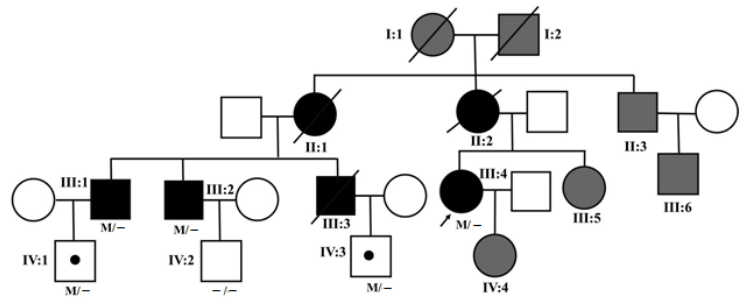
Figure 1. The Chinese pedigree of FAP. Arrow: the proband. Black symbols: affected individuals. Grey symbols: unidentified individuals. Slashed symbols: deceased individuals. Black dots: asymptomatic individuals with the mutation TTR c.401A>G. M: mutation TTR c.401A>G. In this pedigree, the members I: 1, I: 2, II: 1, II: 2 and III: 3 were deceased, and the